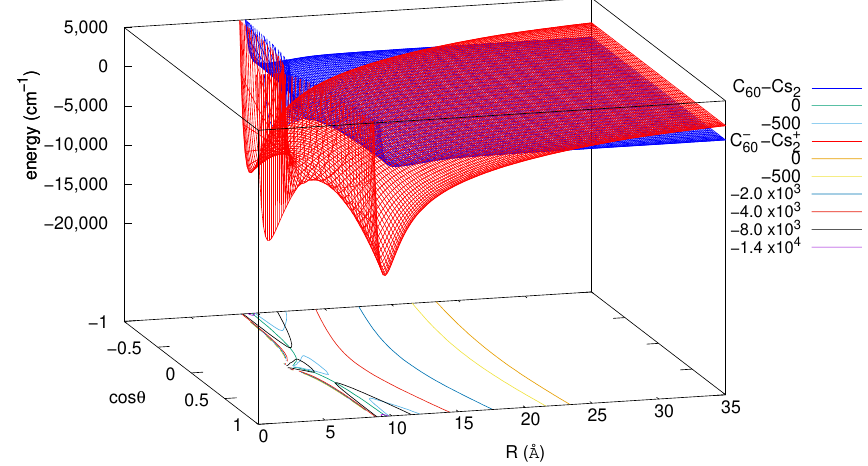
Figure 2. Analytic potential energy surfaces characterizing neutral Cs 2 -C 60 and ionic Cs + interactions as a function of their relative distance R and orientation θ